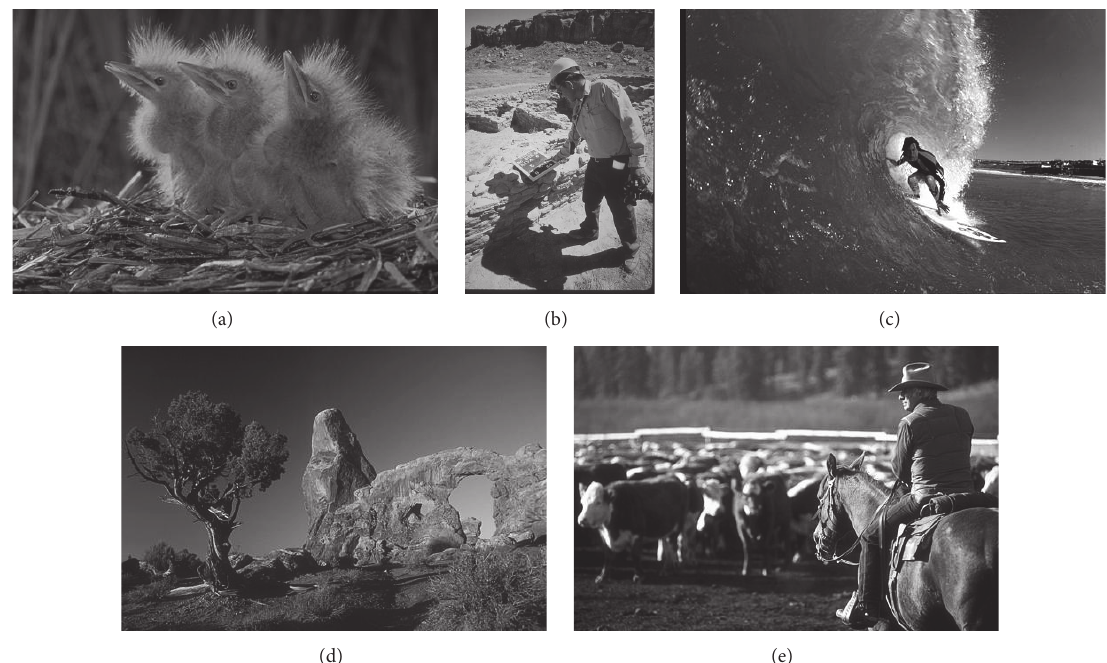
Figure 2: Images for segmentations using the IT2FPCM and IT2FCM